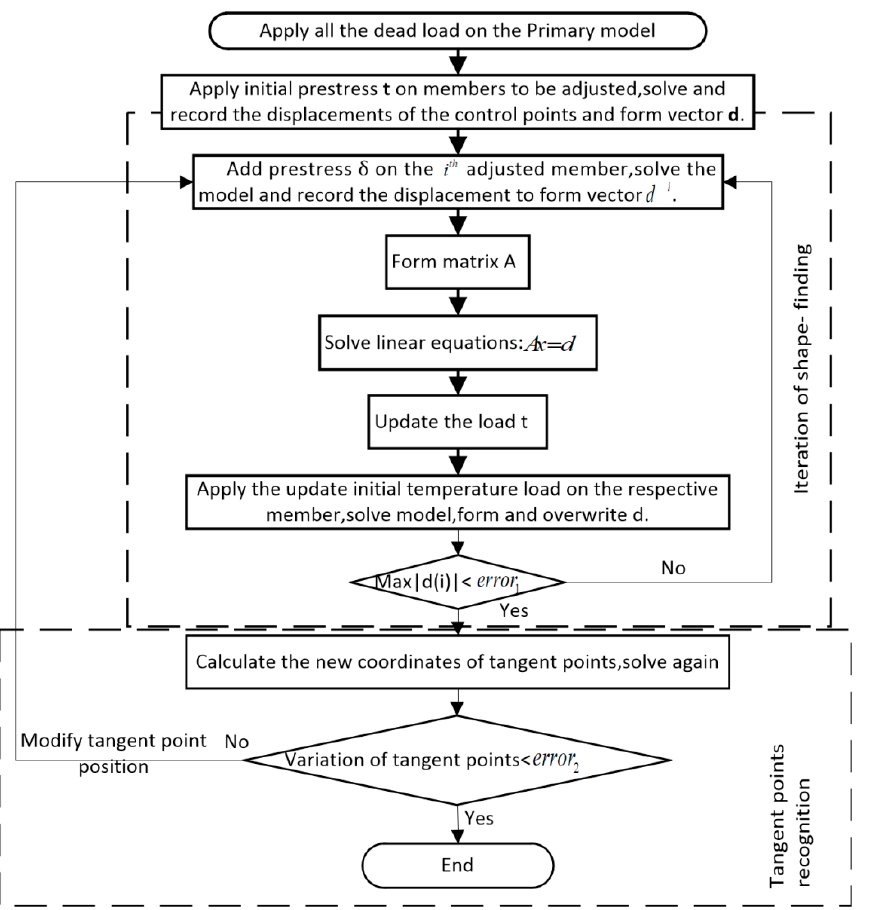
Figure 4. Flow chart for shape-finding, considering saddles.